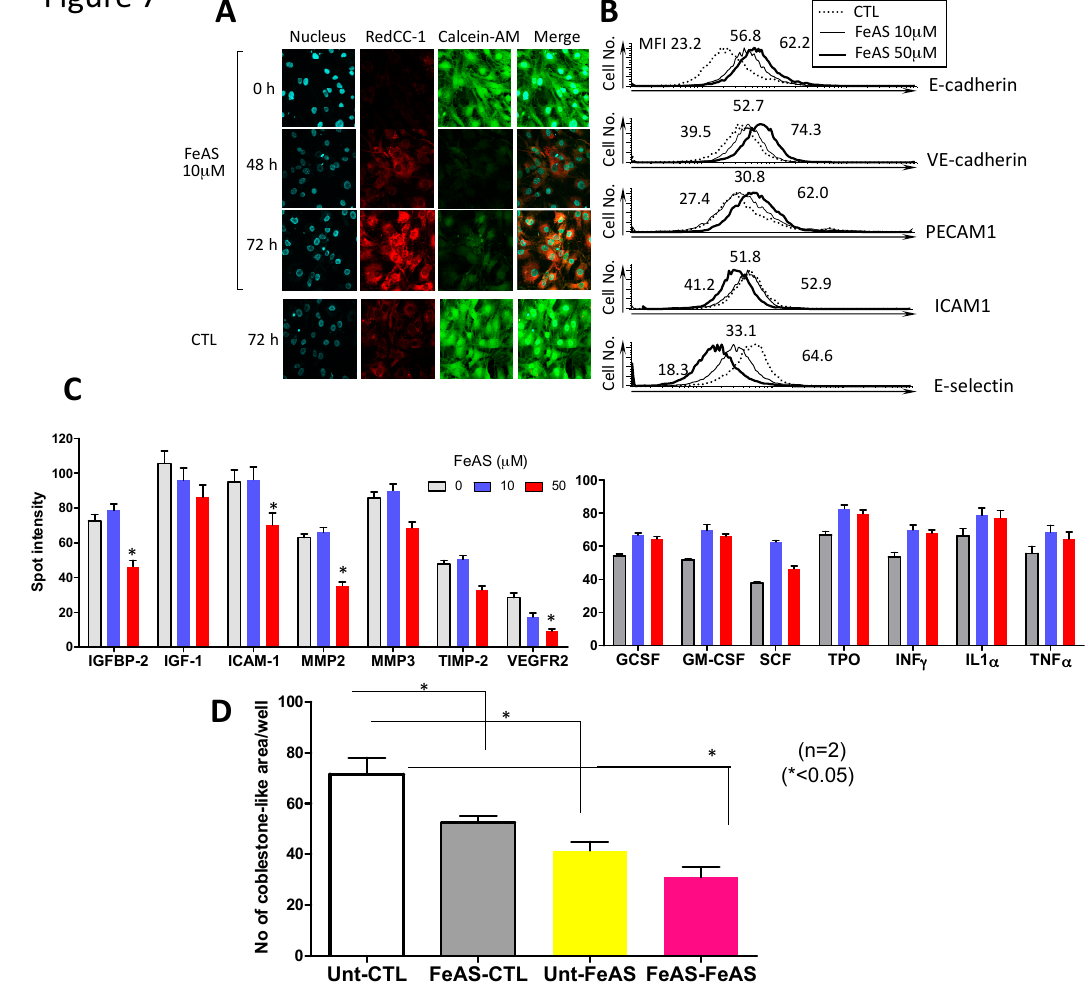
Figure 7. FeAS affects the expression of adhesion molecules on MS5 stroma cells and alters the profile of cytokine production. ( A ) After culture with or without FeAS, MS5 were stained as indicated and analyzed by fluorescence microscopy. Total ROS were detected with Red CC-1, intracellular labile iron with Calcein-AM, and nuclei with Hoechst 33,342. ( B ) After MS5 cells were cultured with or without FeAS for 48 h, cells were stained with the indicated Abs. Representative flow cytometry histograms from three independent experiments are shown. ( C ) Conditioned media were analyzed with a cytokine array and the accompanying kit reagents and protocol. Conditioned media from FeAS-treated (10 or 50 µ M) or untreated MS5 cells (CTL) was collected after 48 h. of culture. Medium supplemented with 10% FBS α MEM was used as a negative control (NC). The assay is arranged in a 14 × 10 grid (Array 3) and a 12 × 8 grid (Array 4), with the configuration shown in Supplementary Data (Figure S1A,B). Summarized densitometry data (mean ± SD) from three independent experiments is shown in the right panel (* p < 0.05). ( D ) MS5 cells were cultured in the presence or absence of FeAS for 48 h, and co-cultured with LSKs with or without FeAS for another 48 h and the number of cobblestone-like areas seen in each well were counted under light microscopy. Summarized data (mean ± SD) from two independent experiments is shown (* p < 0.05). Unt-FeAS: FeAS was present in the culture medium only when MS5 cells were co-cultured with LSK; FeAS-CTL: FeAS was present in the culture medium when MS5 cells were cultured alone but not when they were co-cultured with LSK; FeAS-FeAS: FeAS was present in the culture medium in both, when MS5 cells were cultured alone and when they were co-cultured with LSK cells; and Unt-CTL: FeAS was not present in the culture medium neither when MS5 cells were cultured alone nor when they were co-cultured with